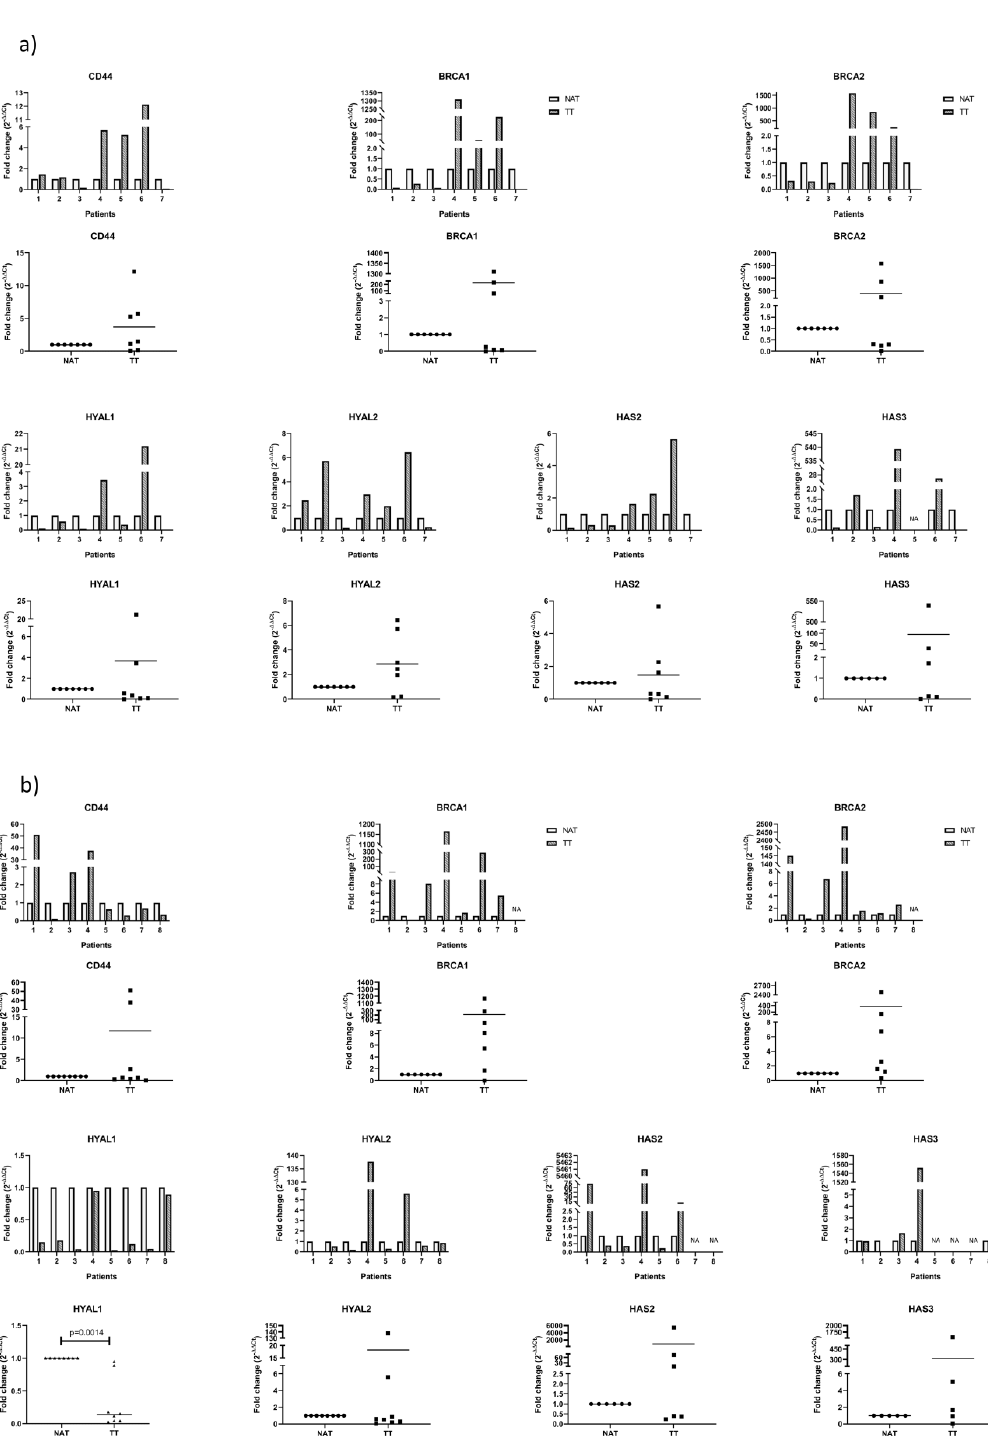
Figure 2. Real Time PCR analysis of the genes involved in HA metabolism and DNA repair. Results were normalized to housekeeping gene GAPDH and shown as tumor tissue (TT ▪ ) relative to non-tumor tissue adjacent to tumor (NAT ●). A P-value lower than 0.5 was considered statistically significant. NA indicates values that could not be obtained. ( a ) mRNA analysis of the tumor (TT) and adjacent non-tumor tissue (NAT) of the colorectal cancer patients. ( b ) mRNA analysis of the tumor (TT) and adjacent non-tumor tissue (NAT) of breast cancer patients.